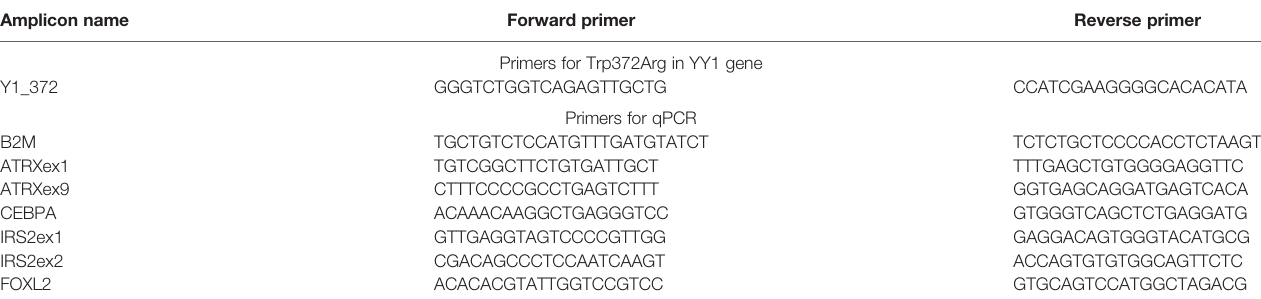
TABLE 1 | Primer sequences for Trp372Arg and qPCR con fi rmations (genome assembly